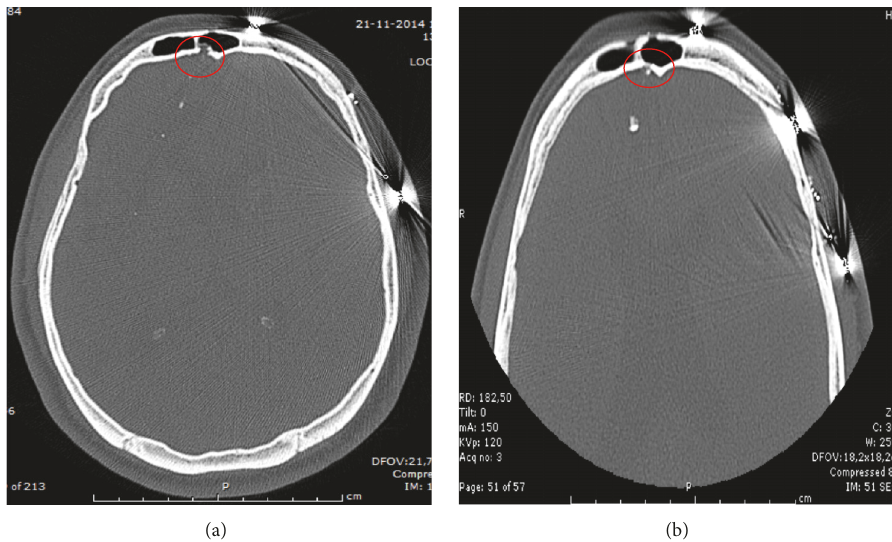
Figure 6: Case 3. (a) Preoperative CT scan showing a CSF leak in the posterior wall of the frontal sinus. (b) Seven-month postoperative CT showing a less dense bony closure of the surgical defect.